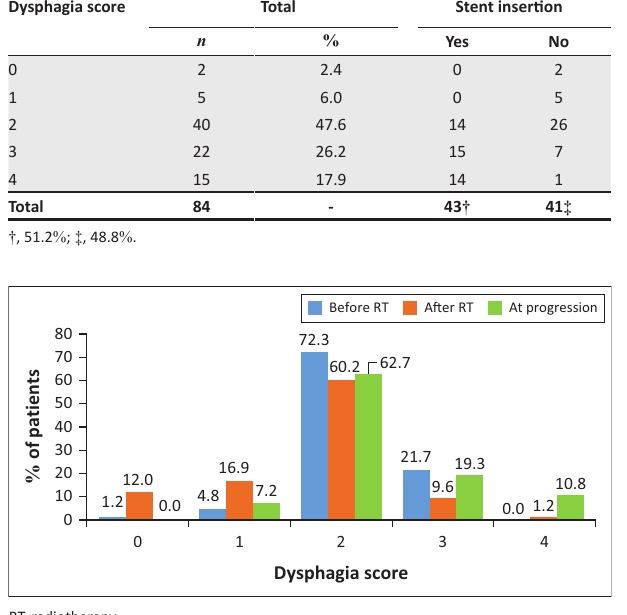
FIGURE 3: Scatterplot showing distribution of DPFS (ungrouped